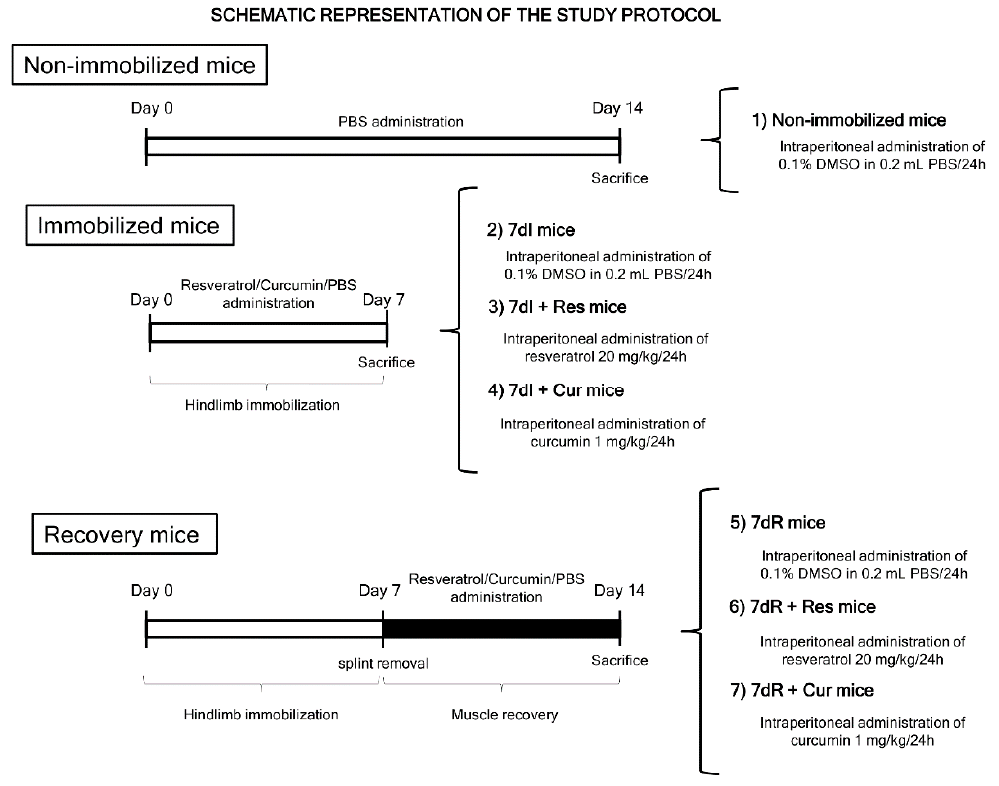
Figure 1. Graphical time-line representation of all the groups and treatments administered to the mice in the study. Definition of abbreviations: PBS, phosphate-buffered saline; DMSO, dimethyl sulfoxide; mL, millilitre; mg, milligram; kg, kilogram; h, hour; I, immobilization; R, recovery; Res, resveratrol; Cur, curcumin.